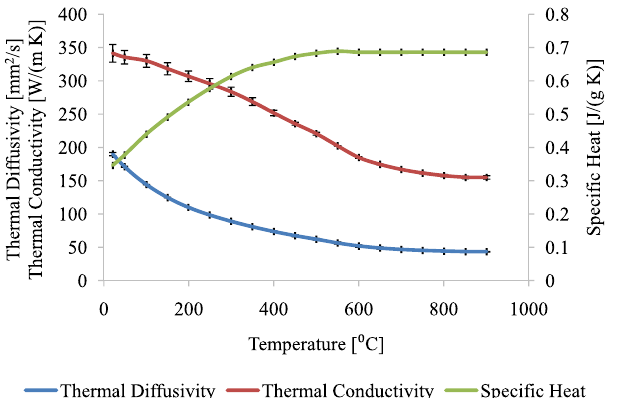
FIG. 7. Plot of thermal diffusivity, thermal conductivity, and specific heat against temperature for CFC along ( L ).